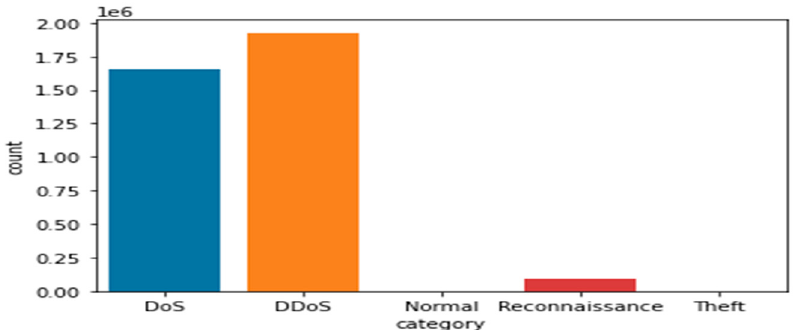
Figure 6. Statistics of considered attacks (the main category) (count is 1 × 1 to the 6th).